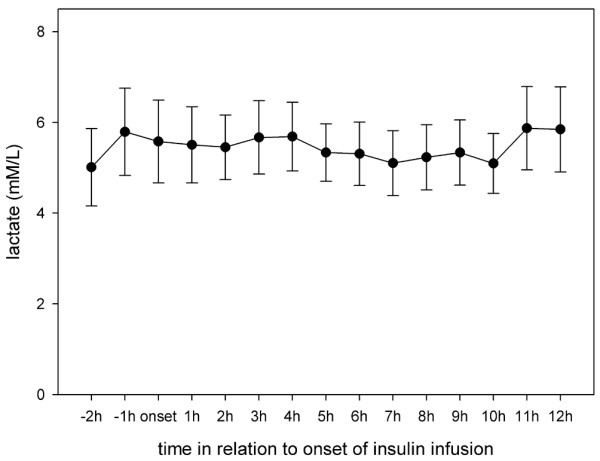
Course of cerebral extracellular lactate during insulin infusion. Data are expressed as mean ± standard error of hourly microdialysate concentrations from 24 patients treated with continuous intravenous insulin.